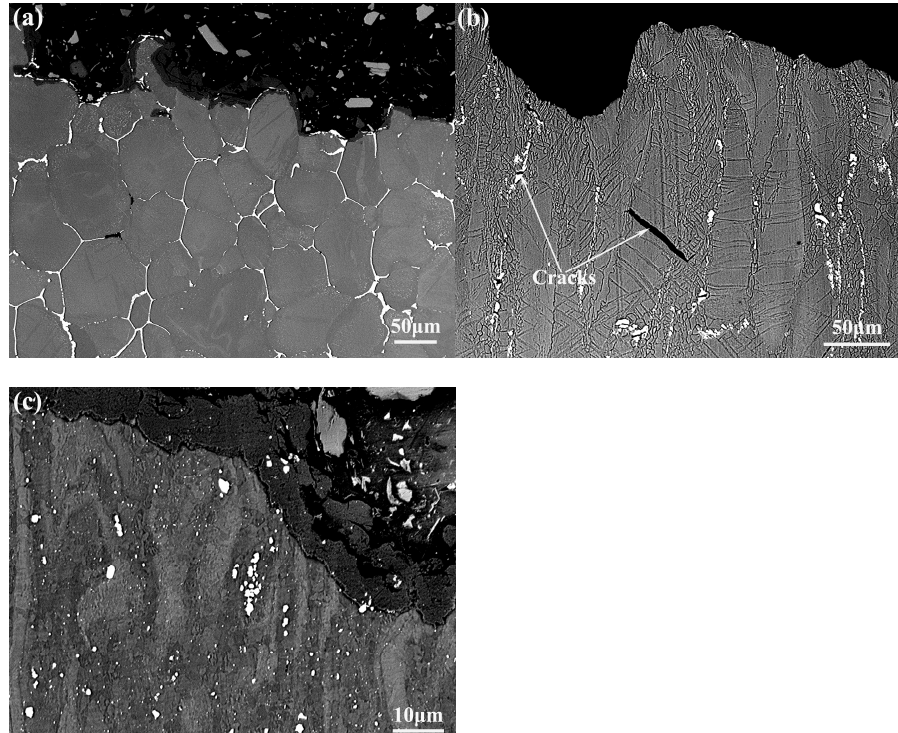
Figure 11. Longitudinal–sectional microstructure of the tensile failed Mg–Zn–Y–Nd alloy with different processing: ( a ) heat treatment, ( b ) one-pass hot extrusion, ( c ) two-pass hot extrusion.